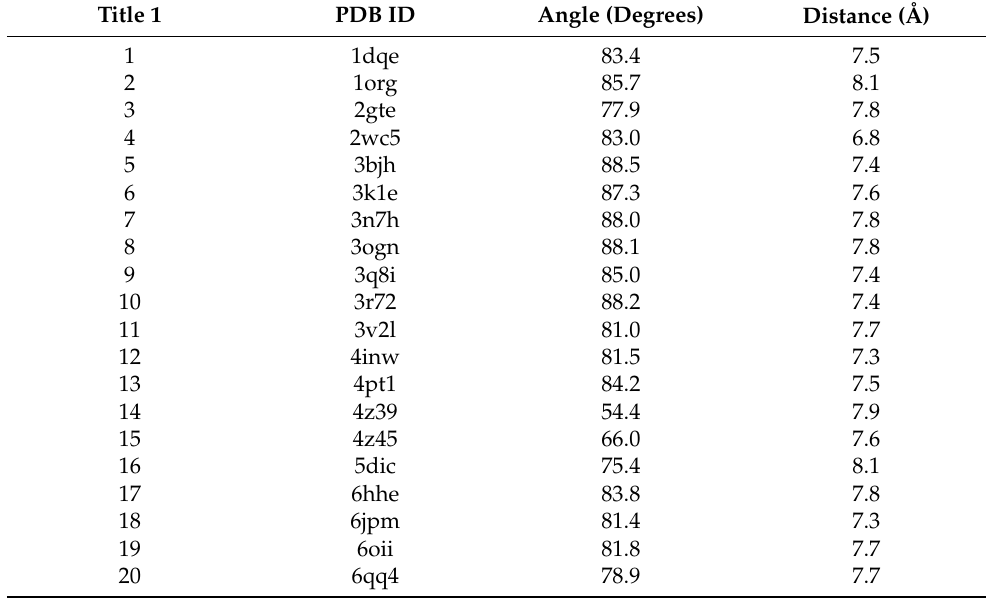
Table A1. Geometric features of the conserved ‘core’